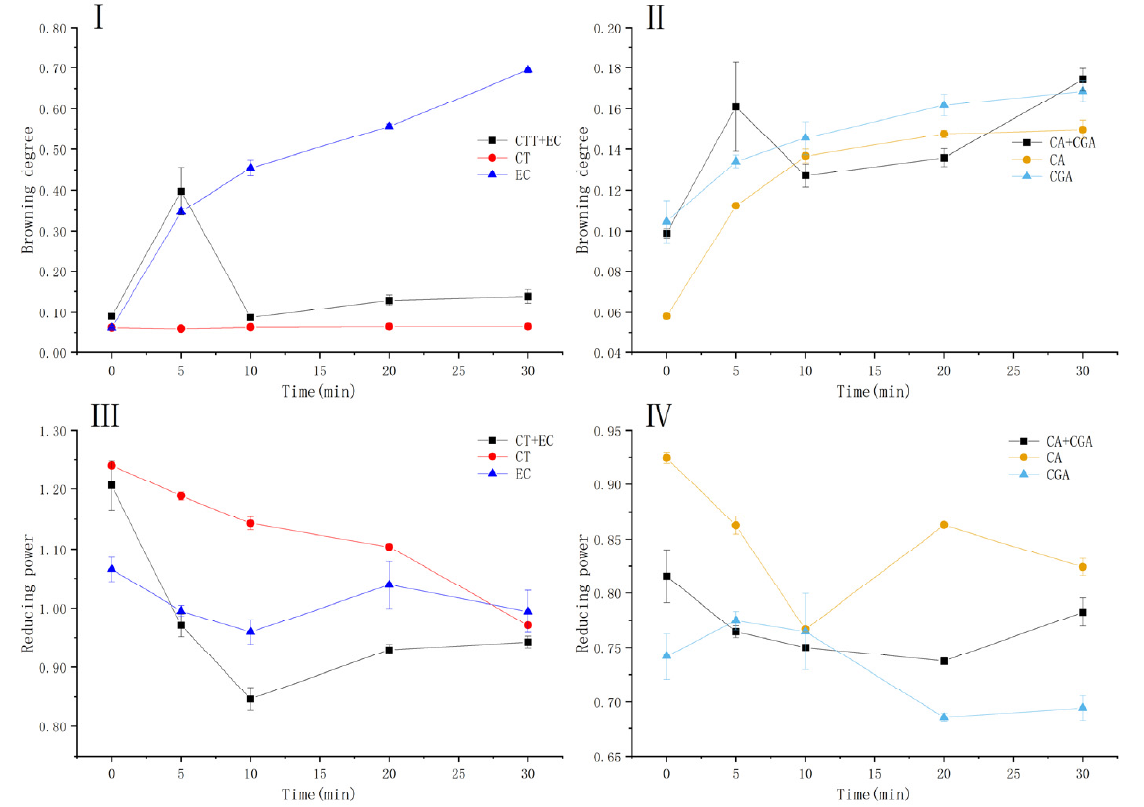
Figure 9. The browning degree and reducing power of enzymatic browning products in various combined substrates ( I,III ) Catechin + Epicatechin ( II , IV ) Caffeic acid + Chlorogenic acid.